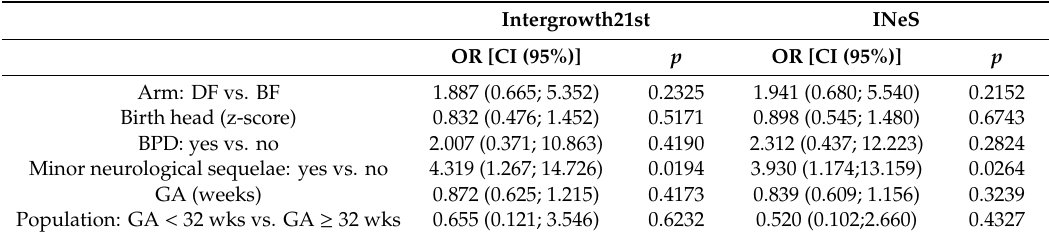
Table 3. Absolute frequencies of General Quotient values lower than and higher than (or equal to) the cuto ff (97.076), defined as the first quartile (q1) of the BF-arm distribution. < Q1 ≥ Q1 BF-arm 13 41 DF-arm 33 Table 4. Odds ratio (confidence interval (95%)) for General Quotient score lower than the cuto ff (97.076), defined as the first quartile (q1) of the BF-arm distribution. Intergrowth21st INeS OR [CI (95%)] p OR [CI